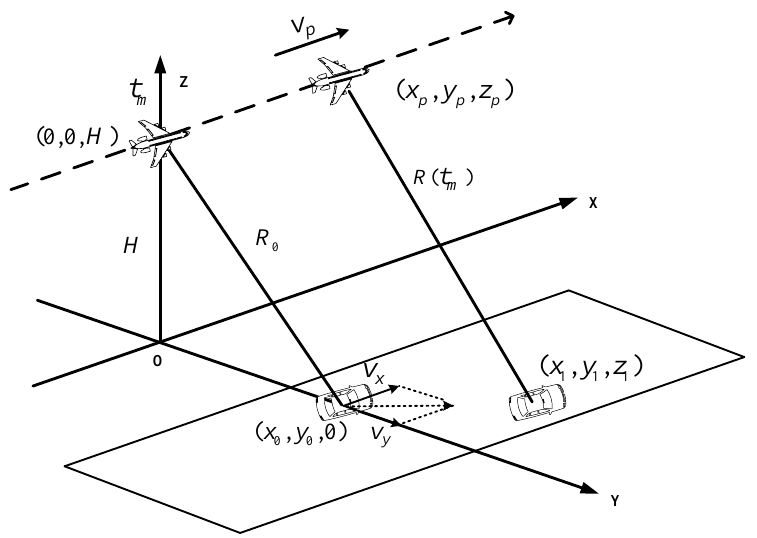
Figure 1. The geometry of the side-looking SAR platform and a ground-moving target. It is assumed that the platform is moving with a uniform velocity v p along the x-axis (azimuth direction) at a height H above the ground and that there is a ground-moving target on the ground whose initial position is at the center of the observation scene with coordinates ( x 0 , y 0 , z 0 ) . The target is moving on the ground with ( v x , v y ) , and v x and v y denote the azimuth and range velocity, respectively. R 0 is the slant range from the platform to the center of the observation scene. t m represents the slow time series, and ( x p , y p , z p